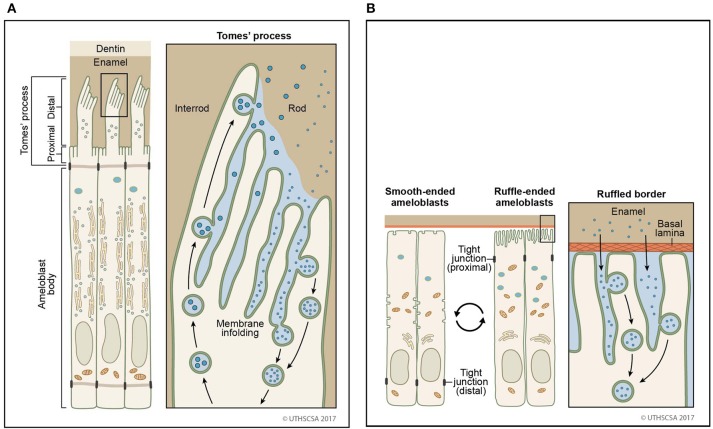
Sites of secretion and endocytosis of the ameloblast membrane. (A) The secretory ameloblasts forms a Tomes' process from the apical membrane with a proximal portion and a distal portion. The proximal portion is associated with formation of interrod enamel, the distal portion with rod enamel formation. Vesicle fusion can be observed on the surface membrane adjacent to the rod growth site. Many vesicles fuse (secretion) or originate (endocytosis) from membrane infoldings found on the proximal portion and the distal portion. (B) In the maturation stage, degraded enamel proteins are internalized by ameloblasts. Ameloblasts modulate between smooth-ended and ruffle bordered membranes. In 80% of the maturation stage, ameloblasts are ruffle-ended with deep membrane invaginations. Degraded enamel proteins from the enamel matrix permeate the area between convoluted tubules and are resorbed via vesicles.